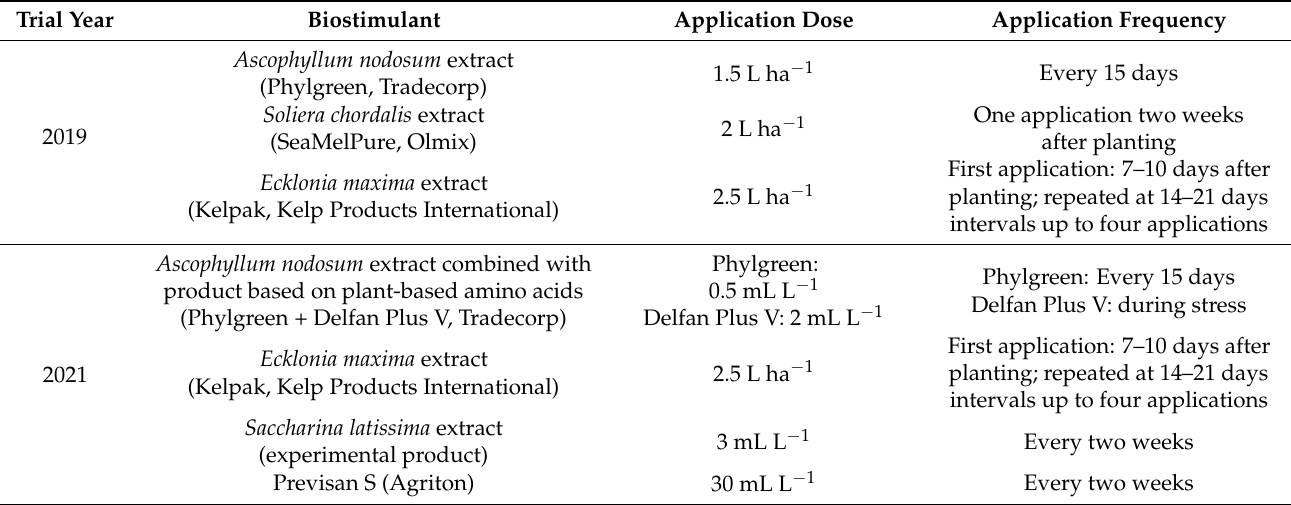
Table 1. Application doses and frequencies of the tested